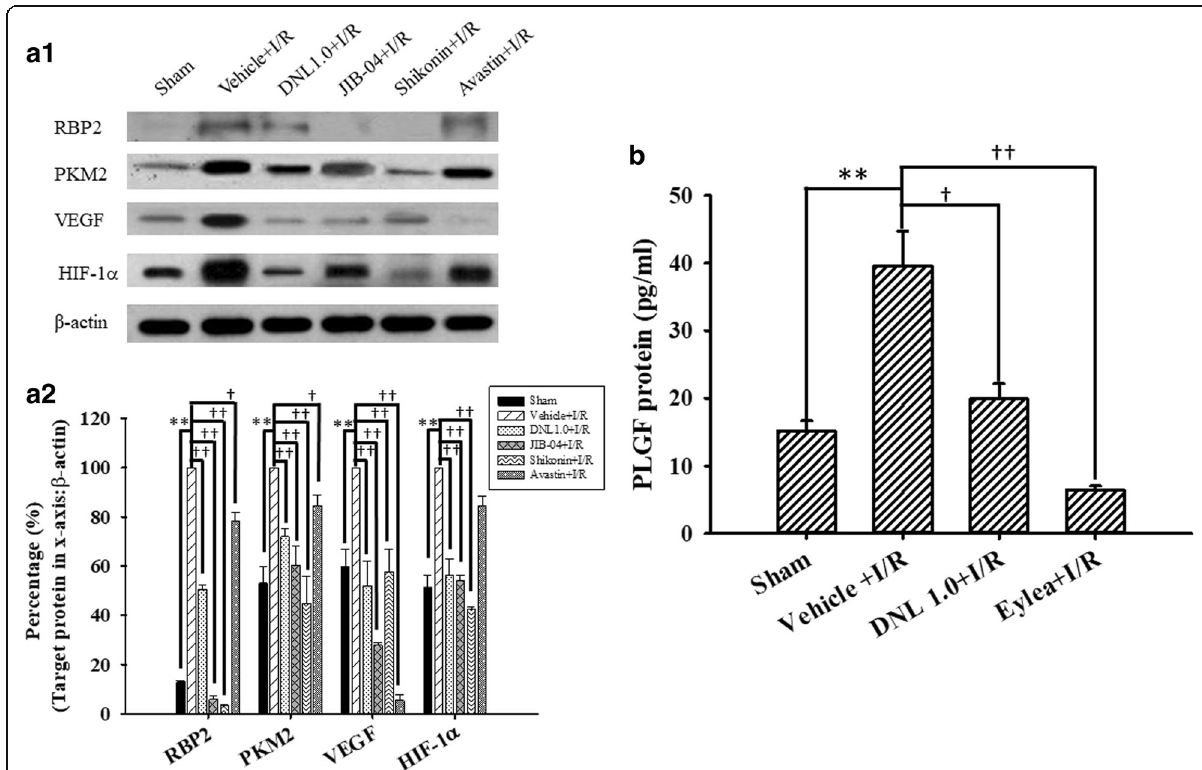
Fig. 8 Western blot analysis showing the expression levels of β -actin, HIF-1 α , VEGF, PKM2 and RBP2. Lane 1 or 2 of picture a1 shows a sham retina subjected to the sham procedure (Sham), or a ischemic retina pre-administered with vehicle (Vehicle+I/R), respectively. Lane 3 shows a retina that received ischemia together with pre-ischemia administration of 1 g/kg/day DNL (DNL1.0 + I/R). Lanes 4~ 6 show retinas that underwent ischemia together with pre-ischemia administration of 10 μ M/5 μ l JIB-04 (RBP2 inhibitor), 4 μ M/5 μ l shikonin (PKM2 inhibitor), or 125 μ g/5 μ l avastin (anti-VEGF), respectively. Each bar in picture a2 represented the ratio of RBP2, PKM2, VEGF and HIF-1 α to β -actin. ** indicates a significant ( P < 0.01) difference between the Sham retina and the ischemic retina pre-administered with vehicle (Vehicle+I/R). † or †† indicated a significant ( P < 0.05 or P < 0.01) difference between the “ Vehicle+I/R ” group and the ischemic retina pre-administered with DNL1.0, JIB-04, shikonin or avastin. The results are presented as means±S.E.M. ( n = 4~ 10). The results of the ELISA assay are presented in picture b . The concentration of PLGF was measured in the retinas obtained from various groups, namely Sham, Vehicle+I/R, DNL1.0 + I/R or Eylea+I/R. Rats that received I/R plus pre-ischemia administration of 200 μ g/5 μ l Eylea was defined as the “ Eylea+I/R ” group. ** indicates a significant difference ( P < 0.01) between the Sham retina and Vehicle+I/R. † or †† indicated a significant ( P < 0.05 or P < 0.01) difference between Vehicle+I/R and DNL1.0 + I/R or between Vehicle+I/R and Eylea+I/R. Results are presented as means±S.E.M. (n = 4).